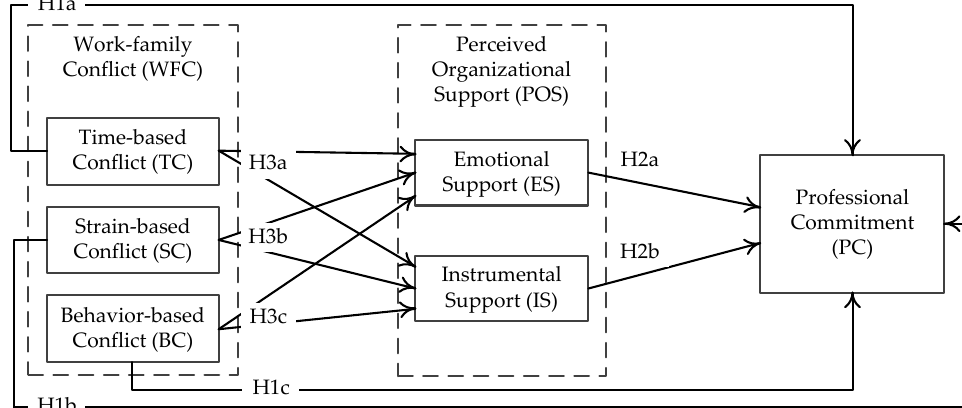
Table 1. Descriptive statistics of the sample.